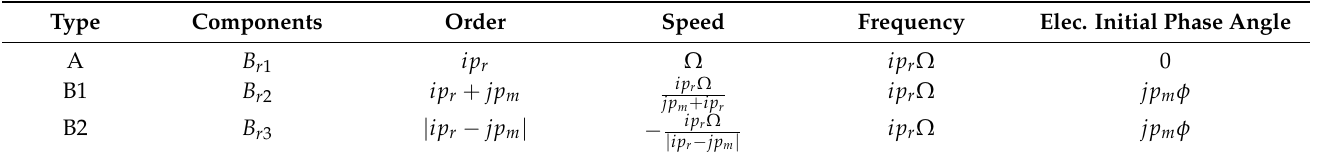
Table 1. Coefficients of the PM harmonic components in the